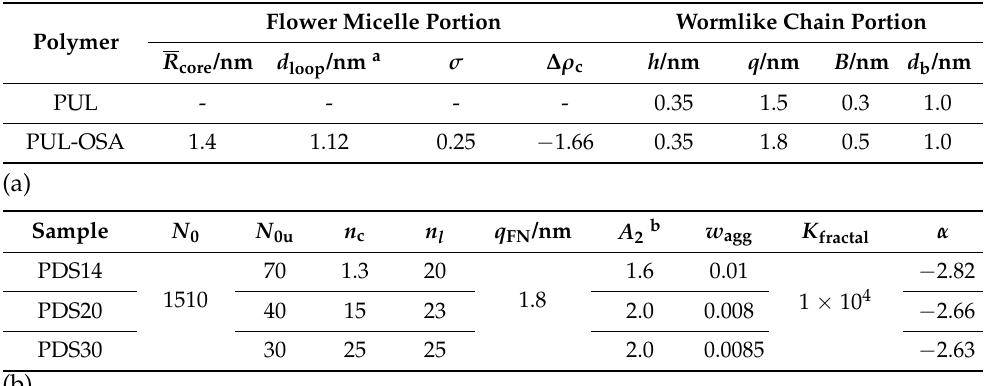
Table 3. Parameters of PUL and PUL-OSA samples in 0.05 M aqueous NaCl used for fitting SAXS scattering functions. Flower Micelle Portion Wormlike Chain Portion Polymer